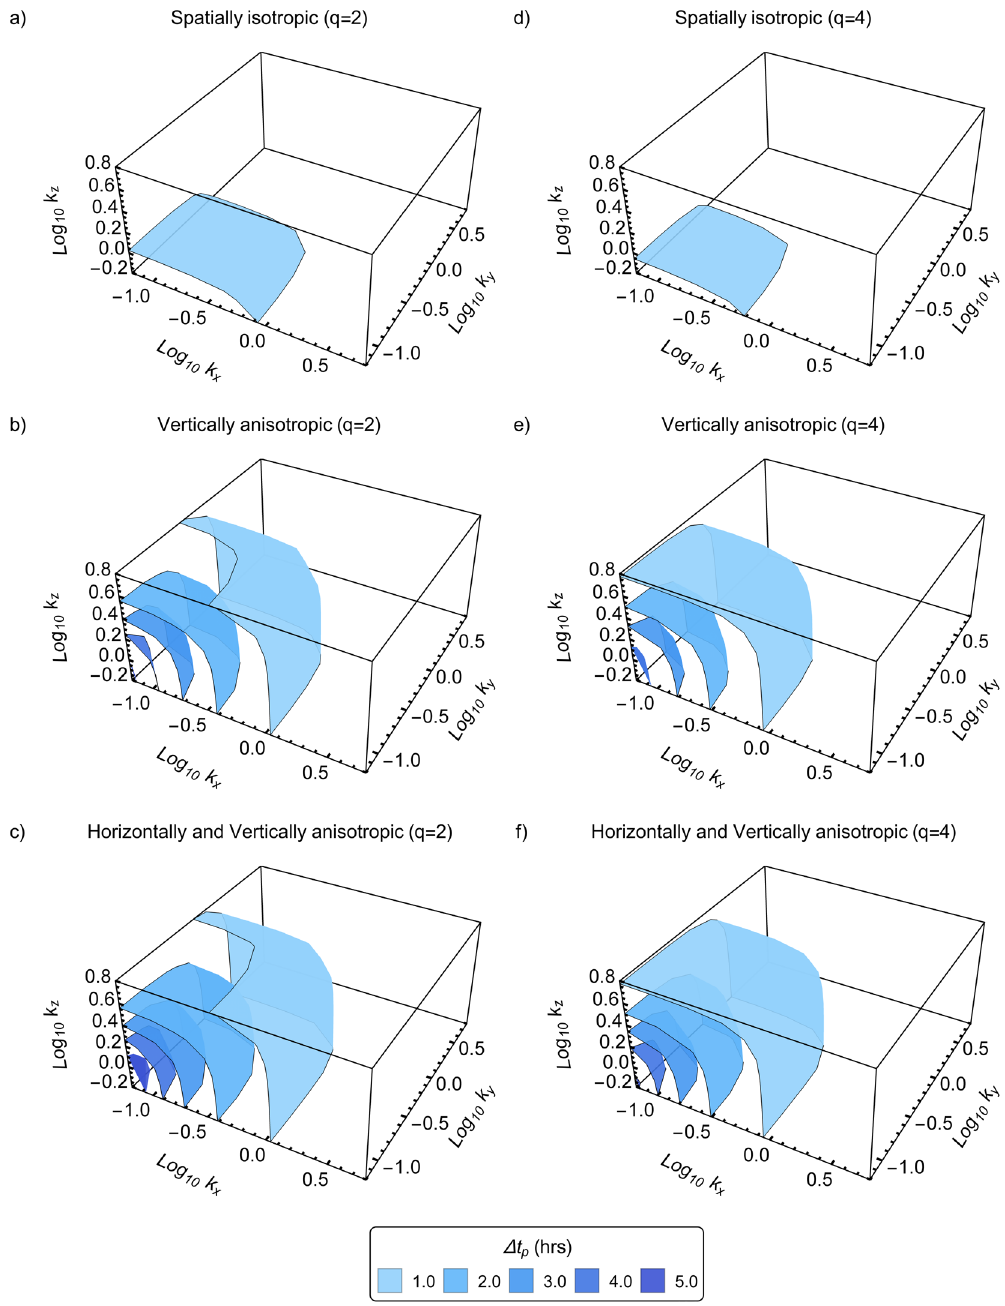
Figure 1. Theoretical predictability limits of spatially isotropic and anisotropic (with 100 m sphero-scale) horizontal wind fields. The wind fields have multifractal parameters α = . = . = . C H 1 5, 0 15, 0 33, and 1 anisotropy parameters as discussed in the text. The wavenumbers k x , k y , k z have units of km − 1 and are in the x , y , z directions respectively, whereas the predictability limits are in hours. The horizontal wavenumbers represent a scale range from 1 to 100 km, whereas the vertical wavenumber represents a scale range from 1 to 10 km (scales smaller than 1 km are not shown here as their predictability limits are less than 1 hour). The two rows differ only by the order of autocorrelation q used in deriving the predictability limits. ( a) spectra based predictability limits ( q = 2) of an isotropic horizontal wind field as a function of logarithmic wavenumber. ( b) same as a , but for vertically anisotropic cases. ( c) same as a , but for horizontally and vertically anisotropic cases. ( d–f) are same as ( a – c ) but for q = 4. Comparing figures ( a–c ) with ( d – f) shows that higher-order predictability limits are smaller than lower-order ones. Since higher-order statistical moments represent more extreme events, these figures indicate that such events are less predictable. Comparing figures ( a – c) with each other and figures ( d – f ) with each other illustrates that fields that are more anisotropic are more